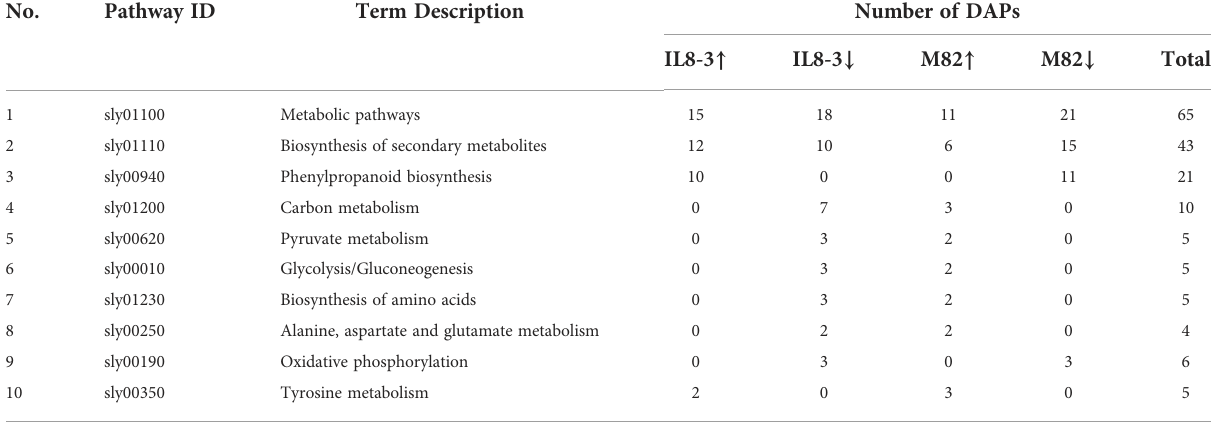
The up and down arrow behind the cultivars represent increased and decreased protein abundance under salt stress, respectively.